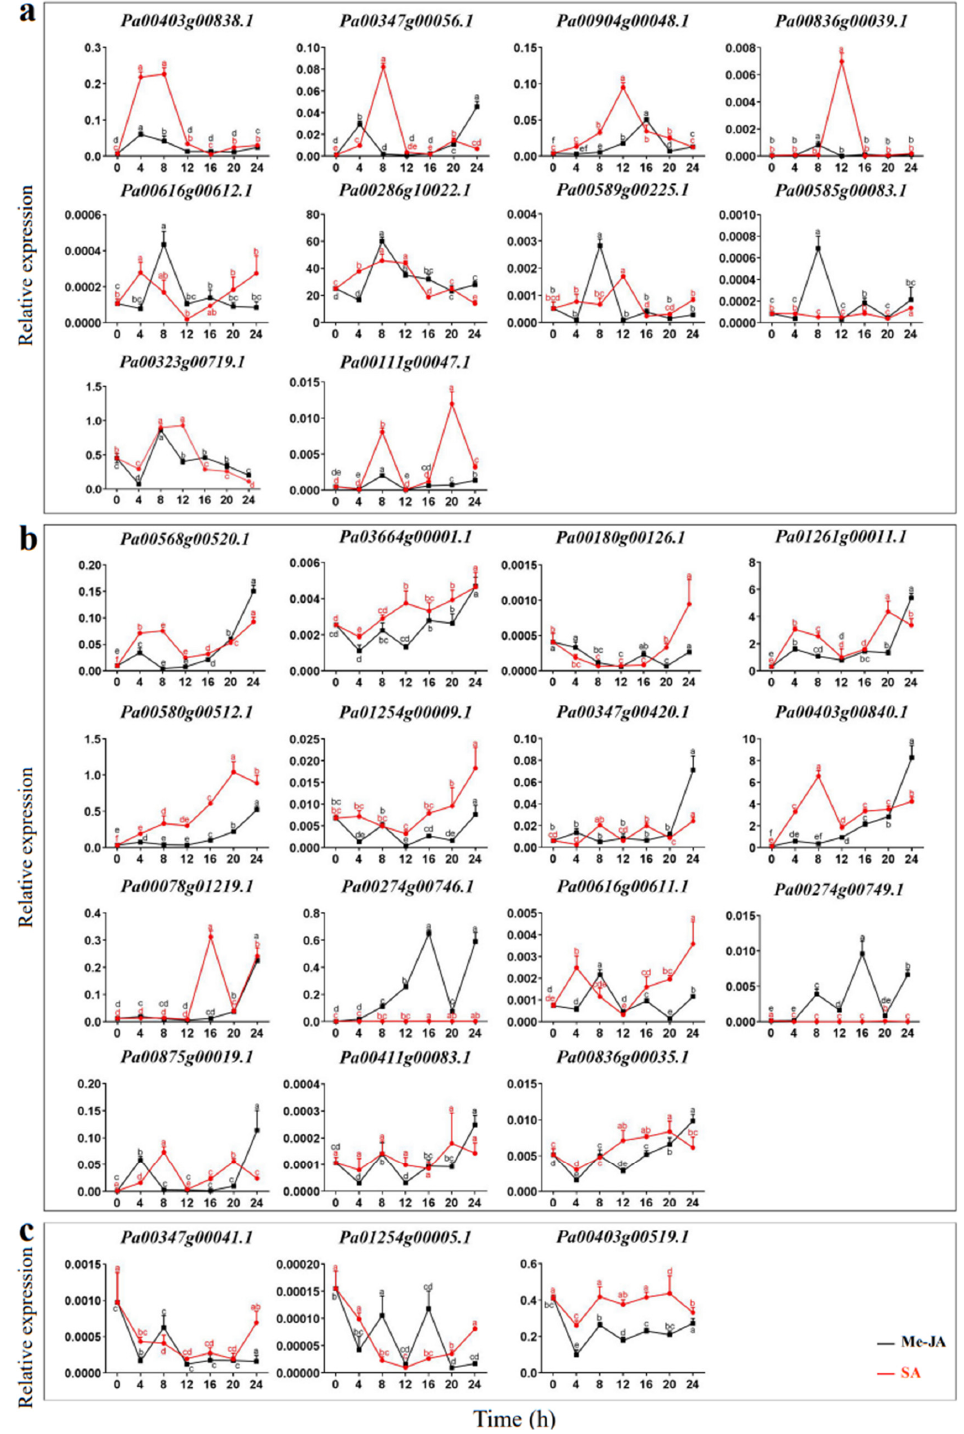
Figure 7. Relative expression patterns of PaCTLs under the treatment of exogenous hormones. ( a ) The expression of PaCTLs showed a fluctuating recovery under the influence of exogenous hormones. ( b ) The expression of PaCTLs showed a fluctuating up-regulated under the influence of exogenous hormones. ( c ) The expression of PaCTLs showed a fluctuating down-regulated under the influence of exogenous hormones. Significant difference between group with variable letters above the line or bar are verified using two-way ANOVA and multiple t -test ( p < 0.05) implemented in the Prism software version